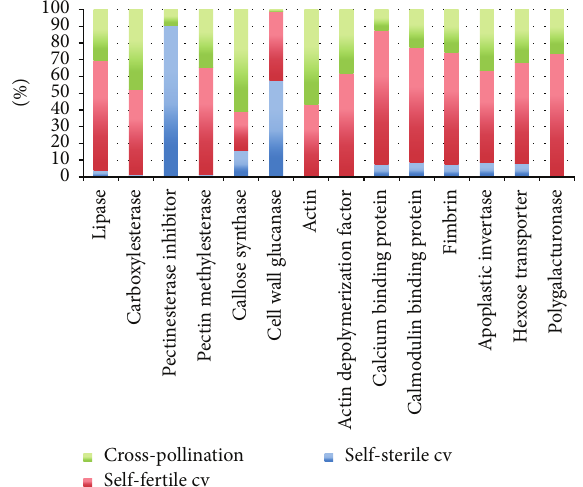
Figure 4: Transcript abundance between samples. Each data is displayed as a stacked bar. Transcript expression levels were taken from the complete FPKM normalized plots that were identified as differentially